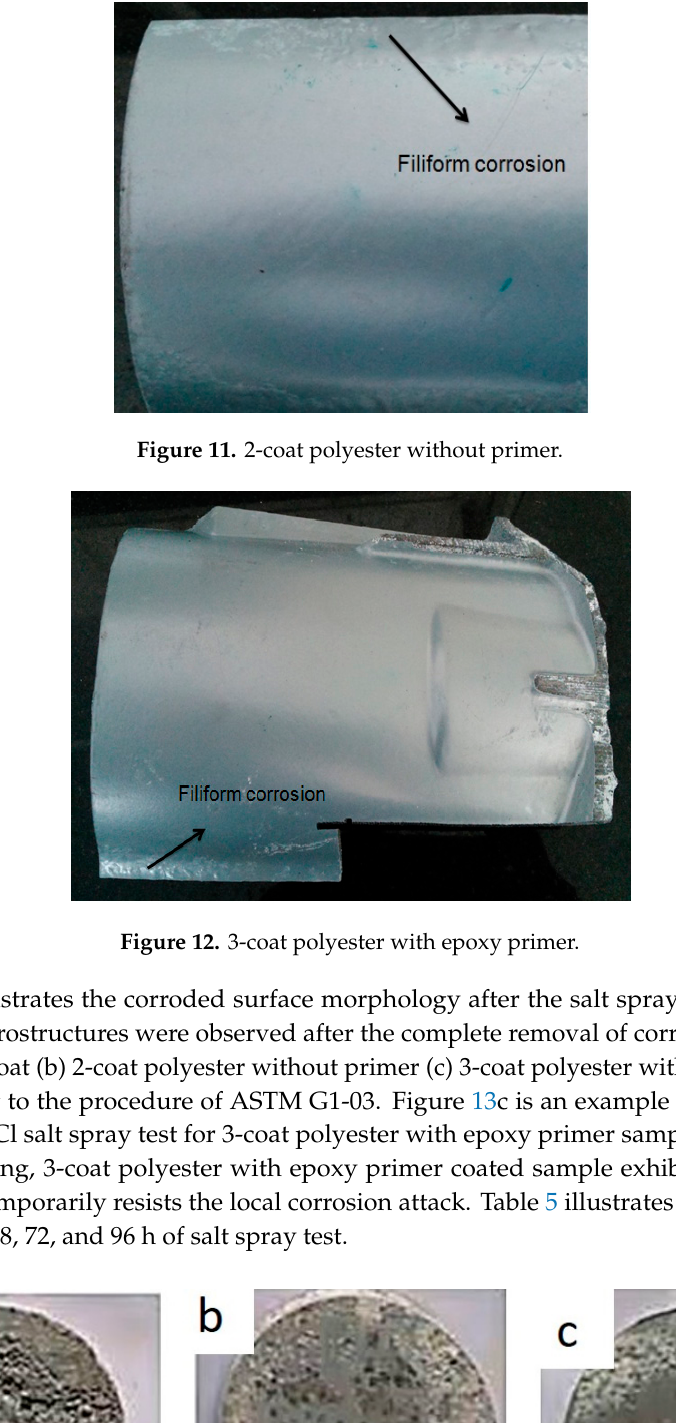
Figure 10. Acrylic paint ED coat.